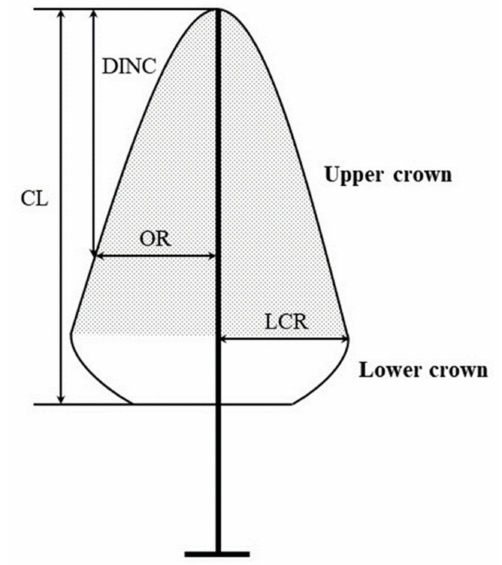
Figure 5. A schematic representation of the crown variables used for crown profile modelling. CL: crown length; OR: outer crown radius, DINC: depth into the crown; LCR: largest crown